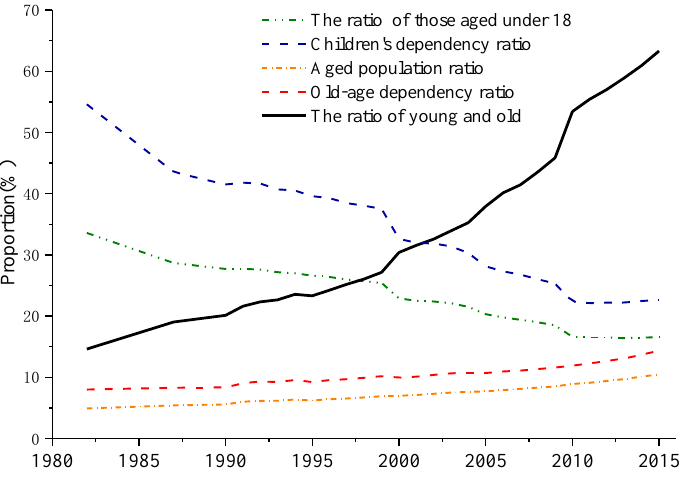
Figure 2. Aging population in China.